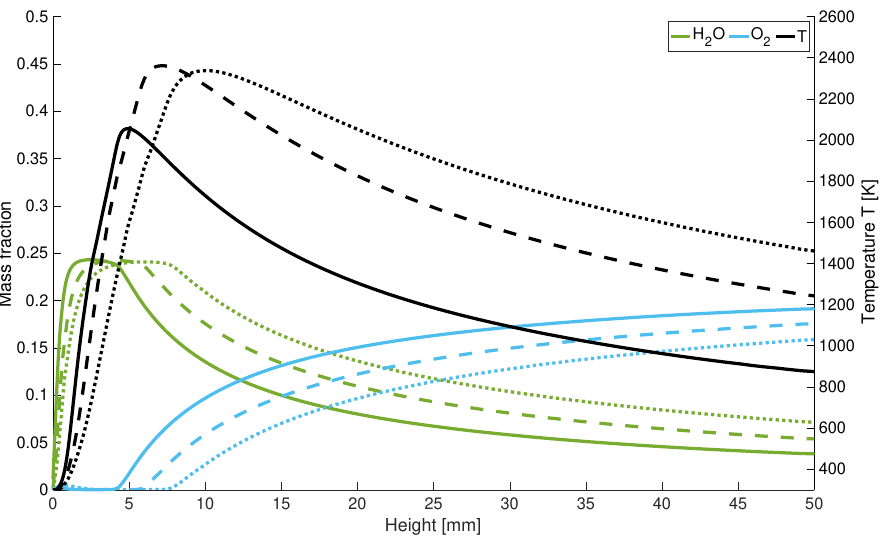
Figure 9. Temperature and mass fraction for different input power; solid line: performance decrease; dotted lines: performance increase; dashed lines: initial